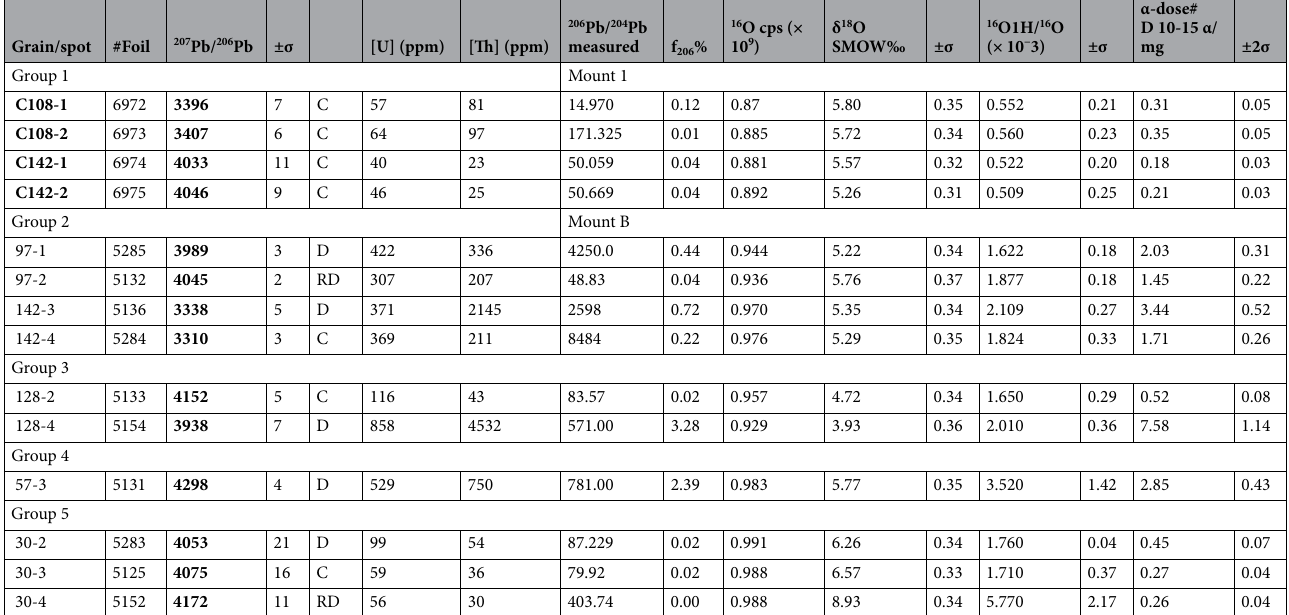
Table 1. Results of U–Th–Pb analyses, together with O–OH data and alpha-dose calculations. Data and grain numbers are from reference 29 . The Pb nanospheres are present in all Hadean and Eoarchean zircon grains, except for Group 2. f 206 % the amount of common 206 Pb, estimated from measured 204 Pb, 207 Pb/ 206 Pb age